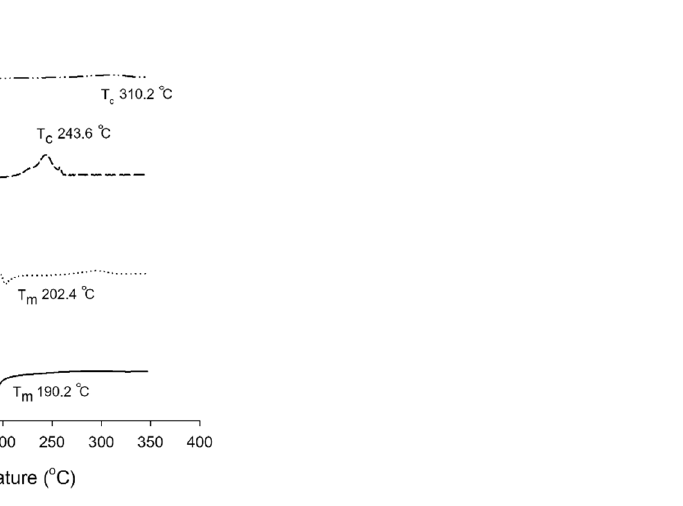
Figure 3. Thermograms by differential scanning calorimeter (DSC) for Mesona chinensis extract (MCE), sodium alginate, control beads, and Mesona chinensis beads (MCB).